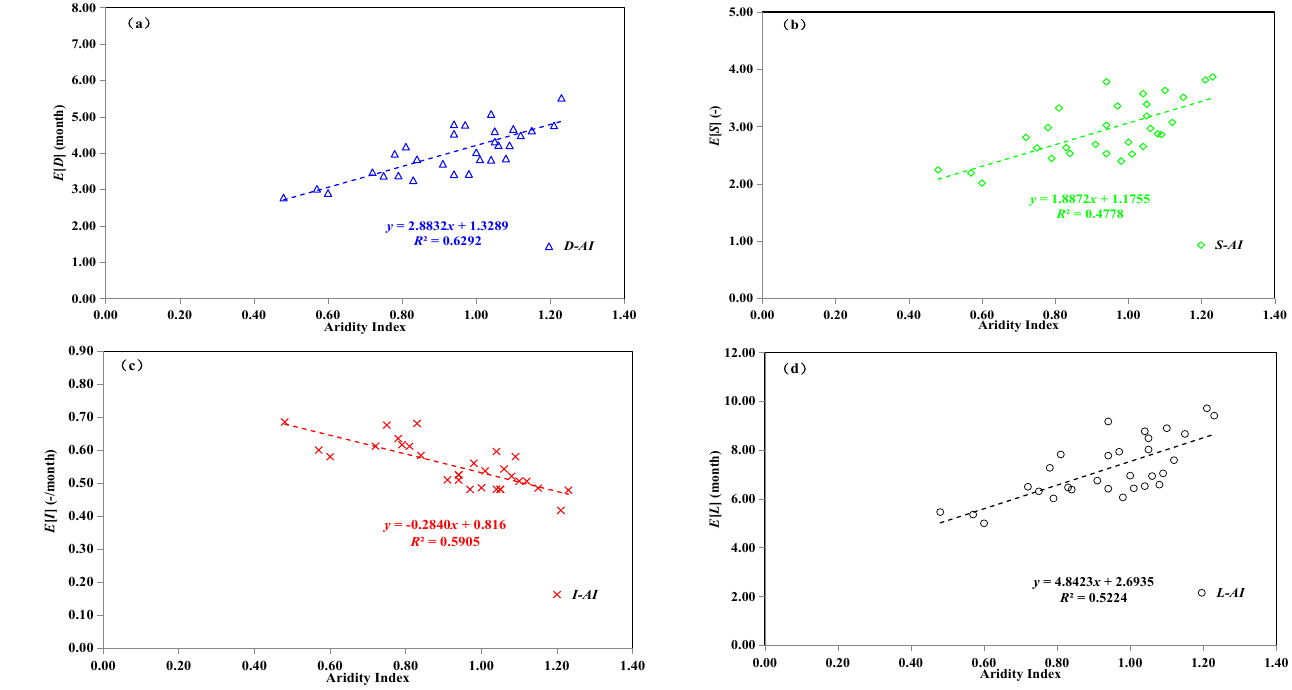
Figure 5. Correlation between Aridity Index and ( a ) E [ D ]; ( b ) E [ S ]; ( c ) E [ I ]; ( d ) E [ L ].